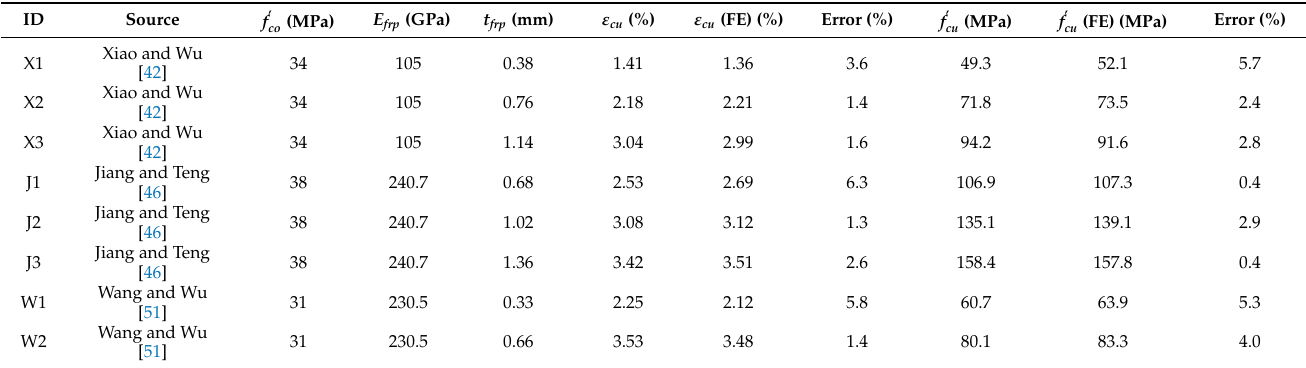
Table 1. Comparison of FE modeling and experimental test